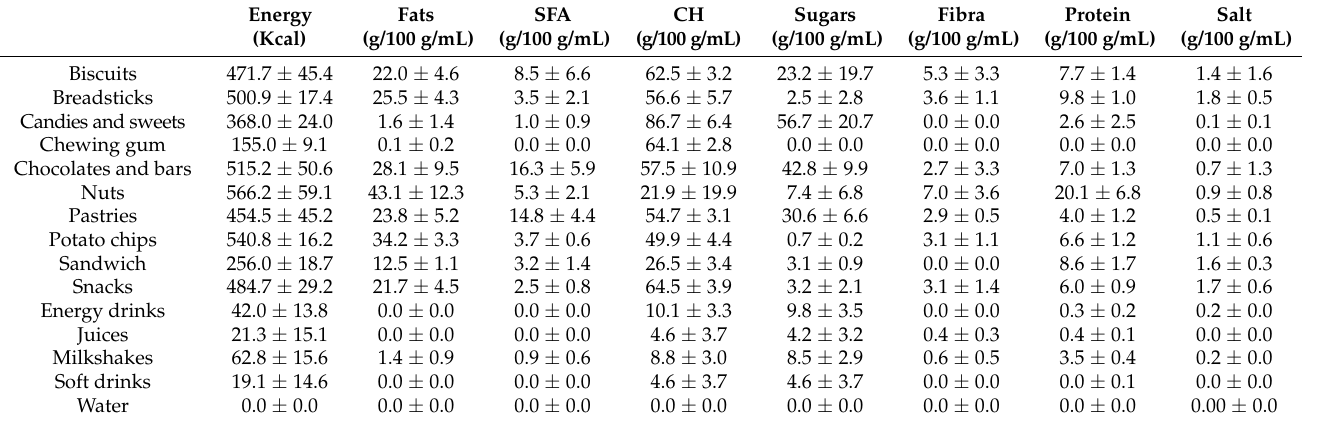
Table 3. Comparison of the nutritional markers of the different categories of food and beverages per 100 g or 100 mL,